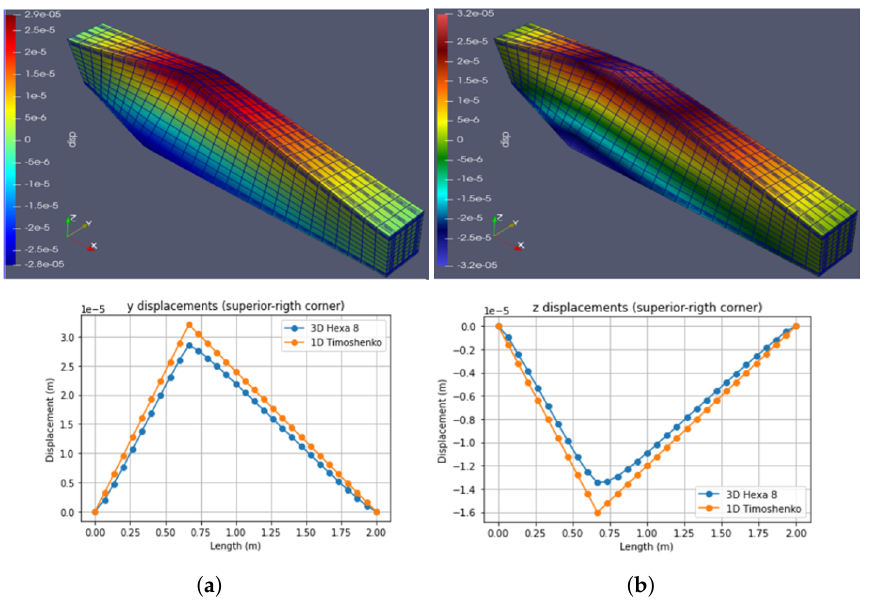
Figure 13. Case 3: Torsional load at L/3 (2800 N.m). ( a ) Hexa8. ( b ) Timoshenko. (Note: e − n indicates 10 − n ).